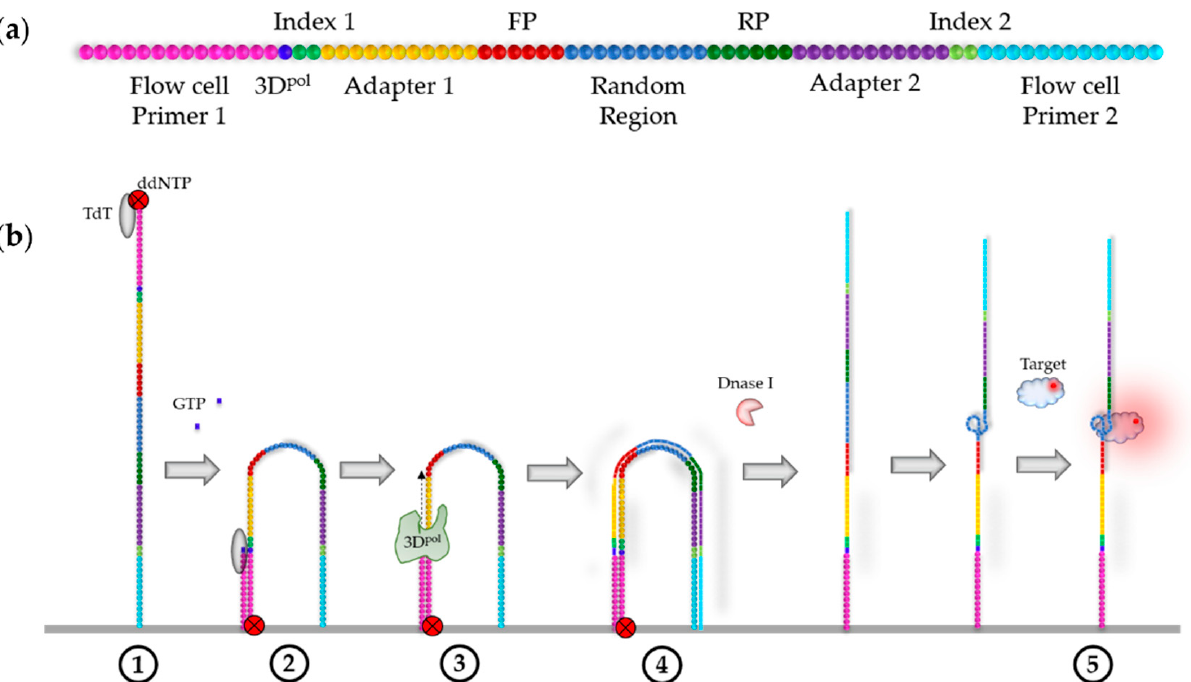
Figure 5. Illustration of HiTS–FLIP with RNA clusters covalently linked to the flow cell, according to Svensen et al. [33]. ( a ) The initial DNA library, designed for paired-end sequencing; 3D pol : initiation site for poliovirus RNAP; FP: forward primer; RP: reverse primer. ( b ) The RNA HiTS–FLIP process, starting from the sequenced DNA strands; TdT: terminal deoxyribonucleotidyl transferase; 3D pol : poliovirus RNAP; GTP: guanosine triphosphate.